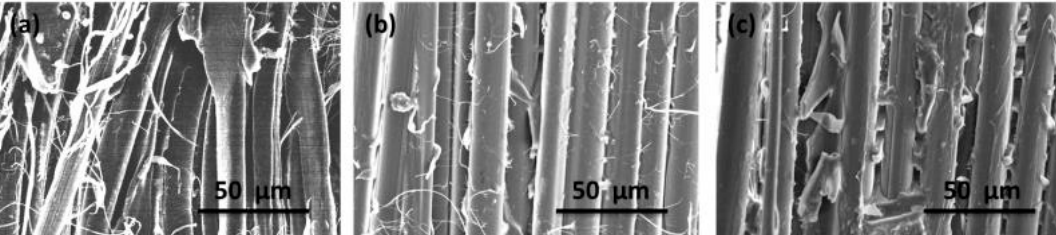
Figure 12. SEM images of fracture aramid fibers/epoxy composites before and after treatment with layer-by-layer self-assembly of L -PDOPA and electrostatic adsorption acidification of silane coupling agents (KH550): ( a ) AF; ( b ) 5L-AF; ( c ) 5L-AF-R.